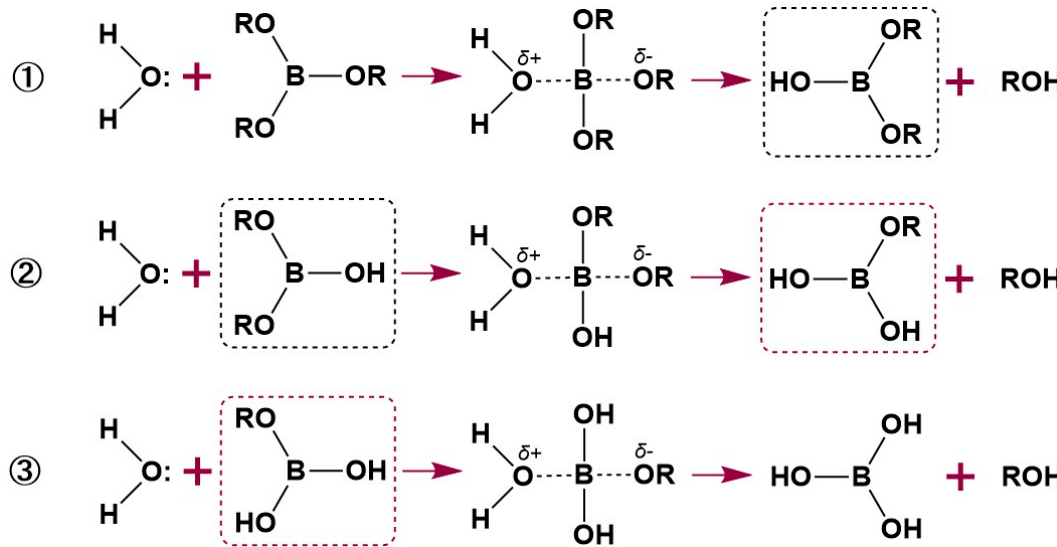
Figure 8. The hydrolysis mechanism of borate esters. Adapted from Steinberg and Hunter, 1957 [41].